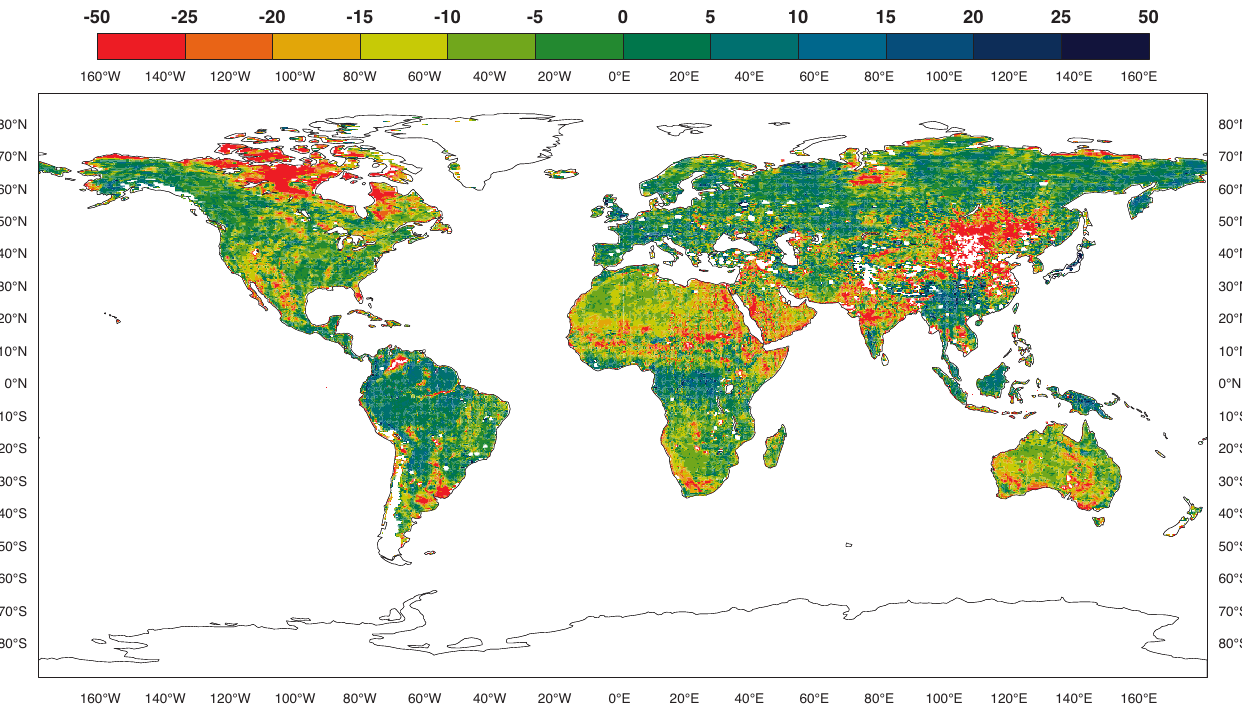
Figure 3. Mean bias (observation-simulation) between SMOS brightness temperatures and model equivalents from 1 to 15 July 2012, at 40 ◦ incidence angle and YY polarisation.